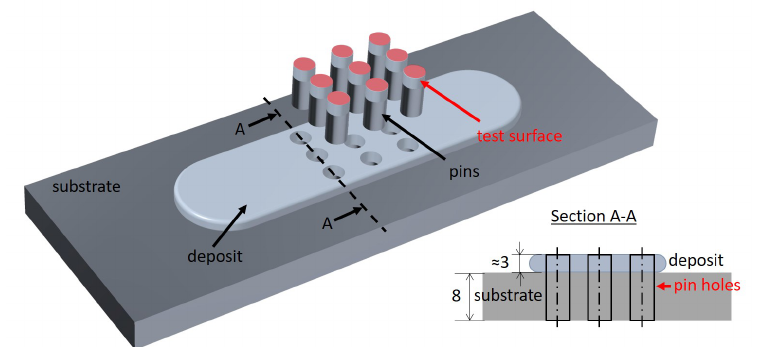
Figure 2. Illustration of pin sample extraction.